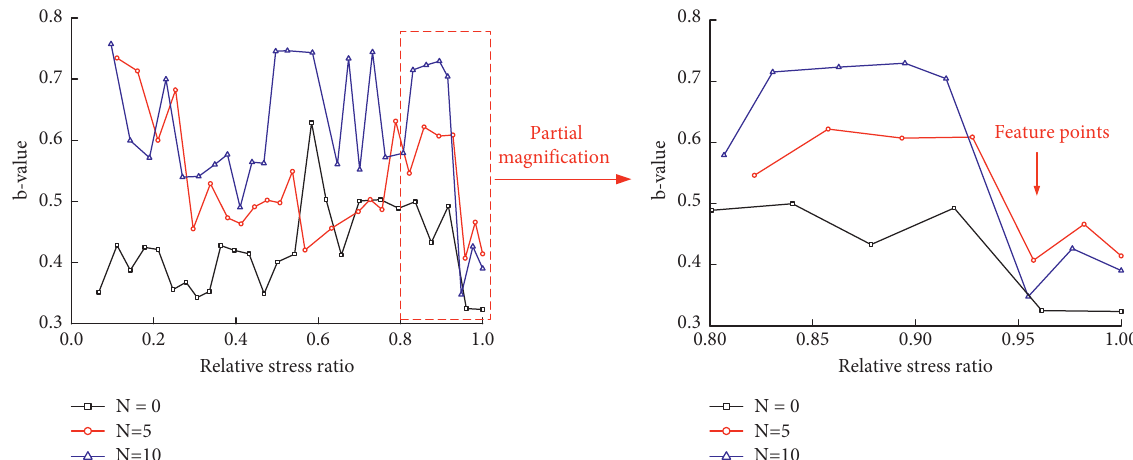
Figure 14: The change in the overall b value in the process of weakly cemented sandstone under different dry-wet